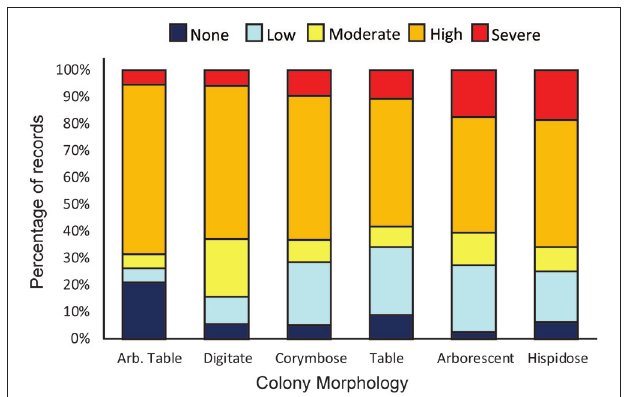
FIGURE 5 | Records of bleaching severity for different Acropora colony morphologies compiled from the literature. Bars show the percentage of records in the literature for each colony morphology in each bleaching severity category ( N = 429). Data for elkhorn and encrusting colony morphologies have been excluded to facilitate comparison with data from Lizard Island plotted in Figure 2B . Numbers of records for each morphology are 19 (Arb. Table), 70 (digitate), 95 (corymbose), 64 (table), 149 (Arborescent) and 32